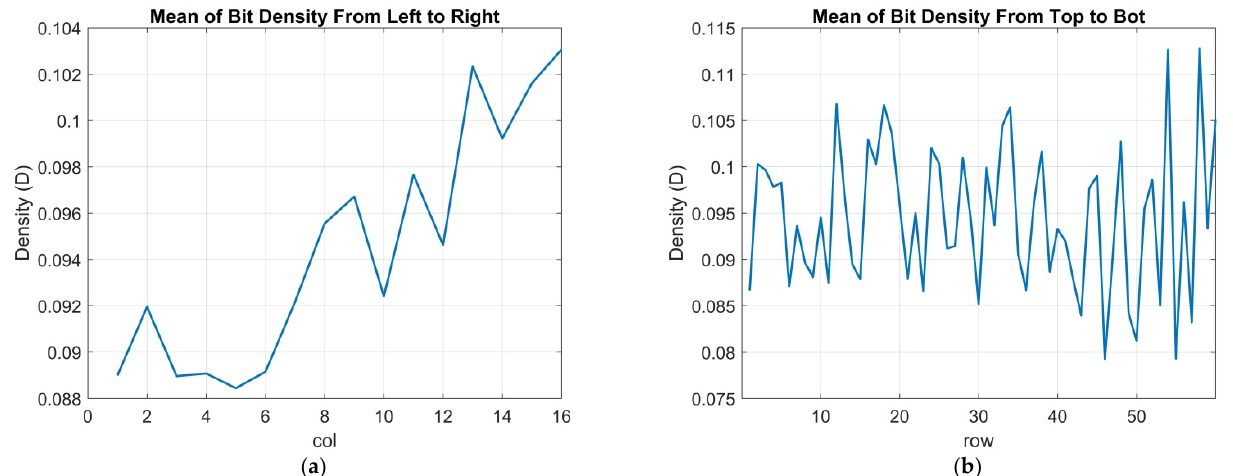
Figure 13. Bit density map for all clusters at H = 10 − 3 .